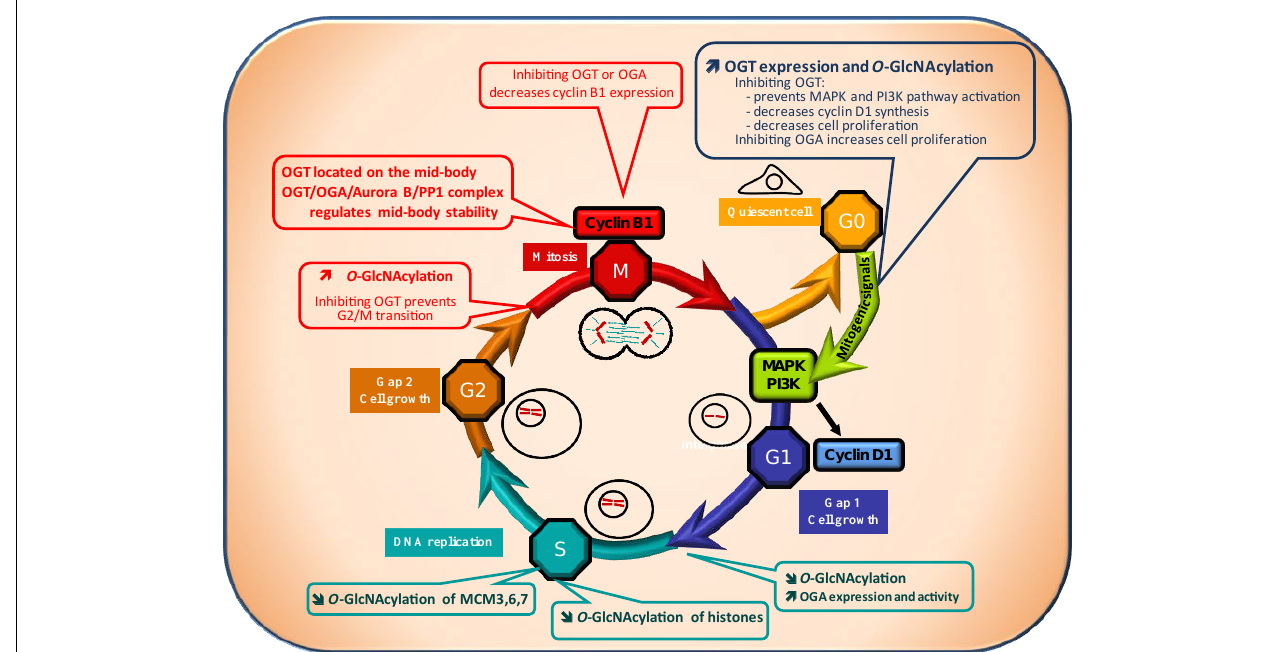
FIGURE 2 | O -GlcNAcylation and cell cycle . A quiescent cell enters the cell cycle upon mitogenic signals. Cell cycle is divided into four phases: the G1 (Gap1) phase, during which cell grows, followed by the S phase of DNA replication, then the G2 (Gap2) phase which prepares the cell for the proper division phase called M phase. Progression of the cell through the different phases is highly controlled: at the G1/S and G2/M transitions a checkpoint exists to ensure that DNA is not damaged respectively before and after its replication.The G2/M checkpoint also controls that replication is ended before division of the cell into two daughter cells genetically identical. O -GlcNAcylation levels have been found to vary all along the cell cycle suggesting that it could regulate this process. OGT and O -GlcNAcylation levels increase when quiescent cells are stimulated by mitogenic signals to enter into the cell cycle (G0/G1 transition). On the contrary, OGA activity is increased at the G1/S transition leading to a decrease in global O -GlcNAcylation levels. At the G2/M checkpoint, a